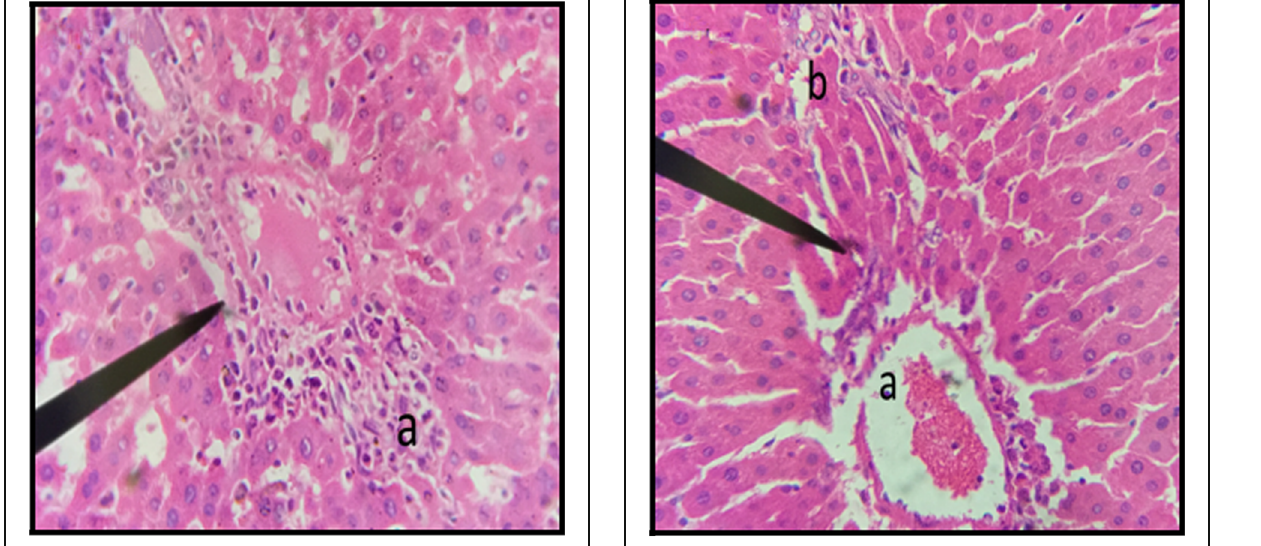
Fig. 14 Liver Section of Female Rat (50 mg/kg/day) X400. a Fig. 16 Liver Section of Female Rat (100 mg/kg/day) X400.